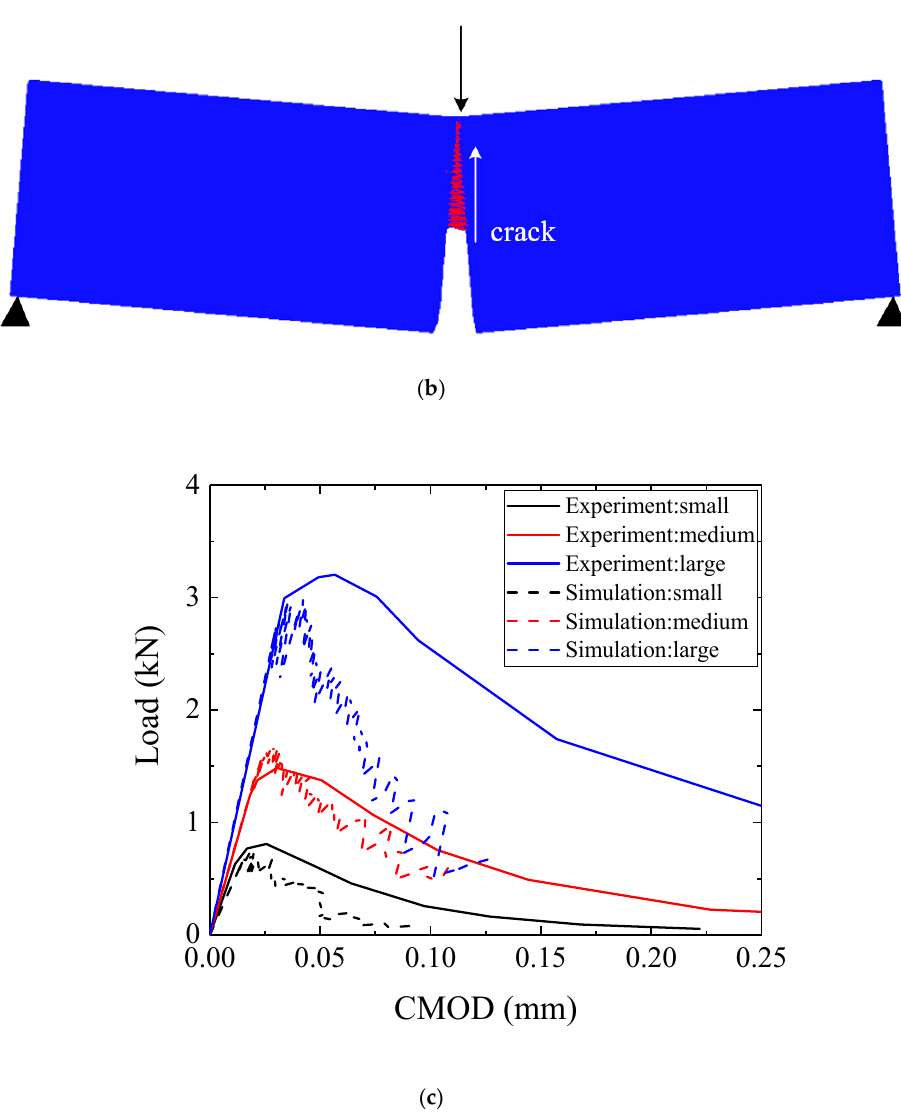
Figure 9. ( a ) Geometry of three-point bending test specimen, ( b ) the comparison between experimental results with numerical results for three-point bending test, ( c ) crack pattern for the three-point bending test (red-cracked element; deformations have been scaled for clarity).